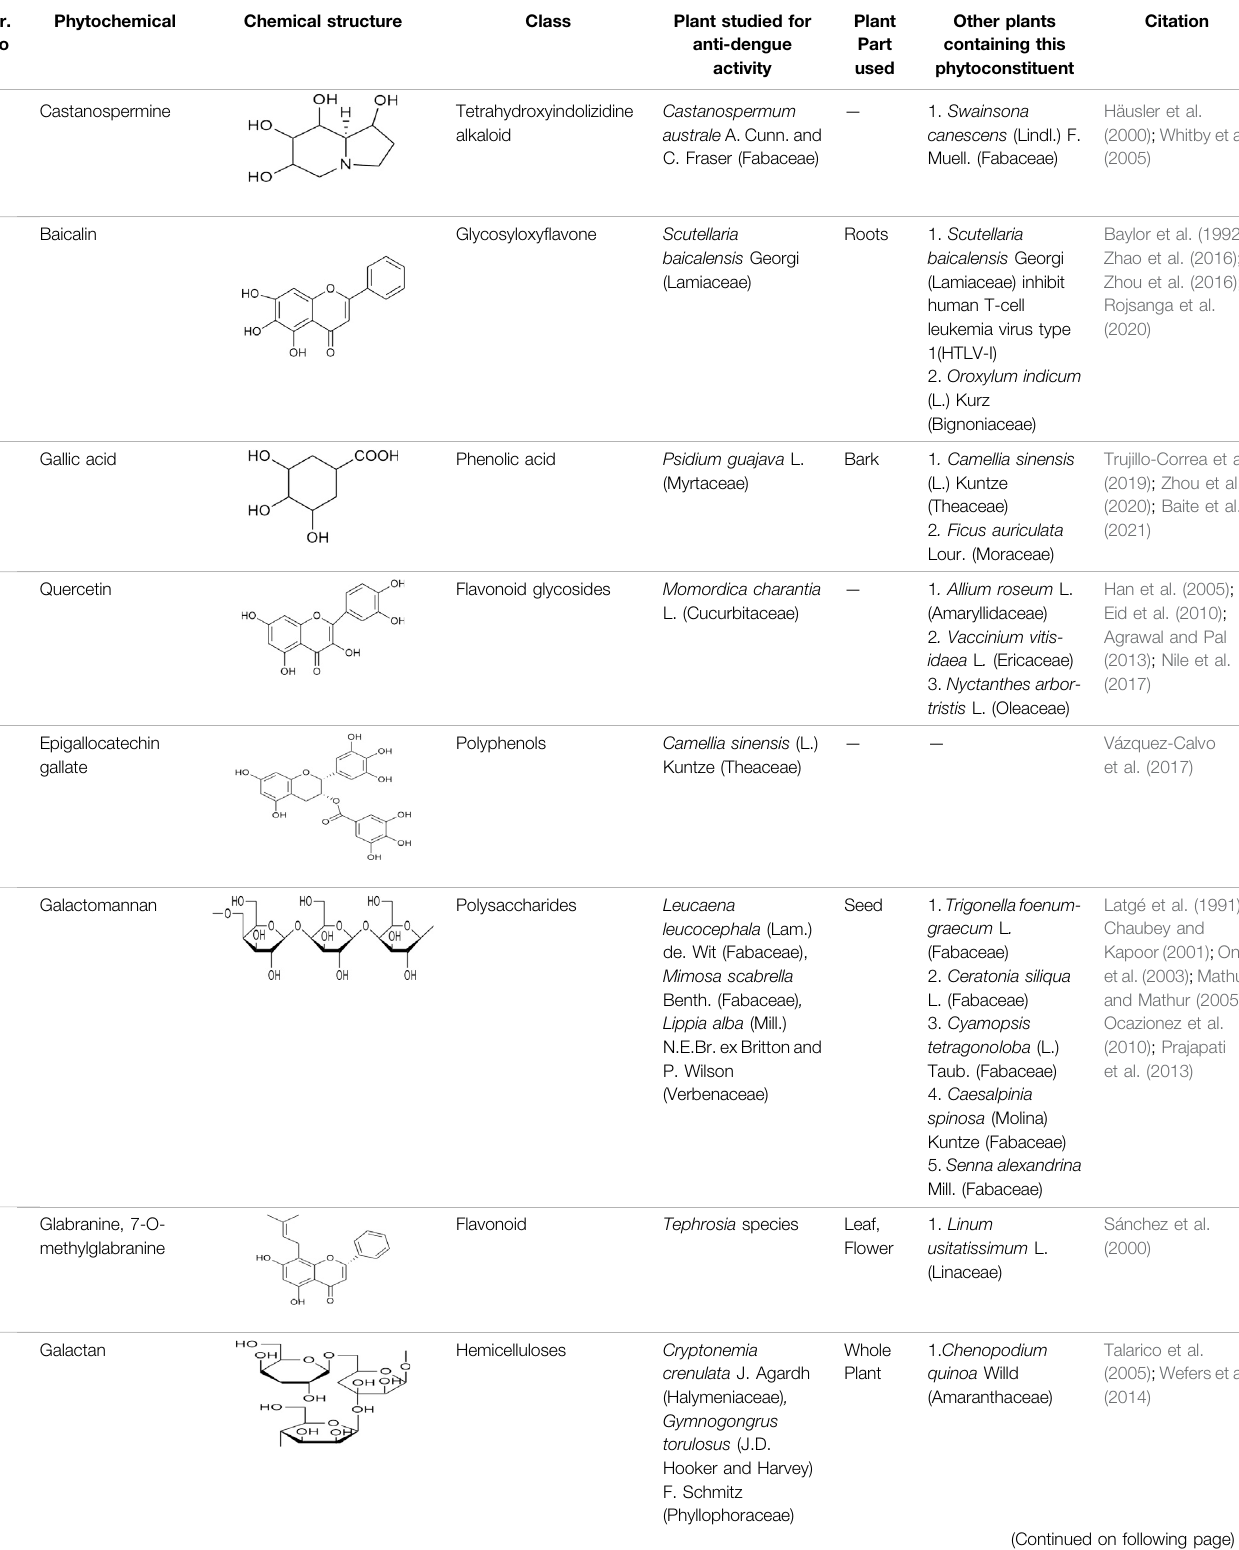
TABLE 3 | Effective bioactive compounds from plant sources against dengue